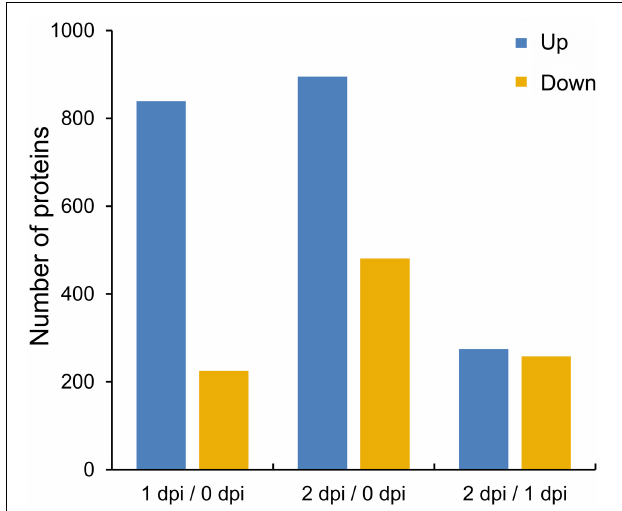
FIGURE 2 | The numbers of upregulated and downregulated proteins in maize stem following Fusarium graminearum infection. A cutoff of 1.3-fold and p -value < 0.05 were used to select